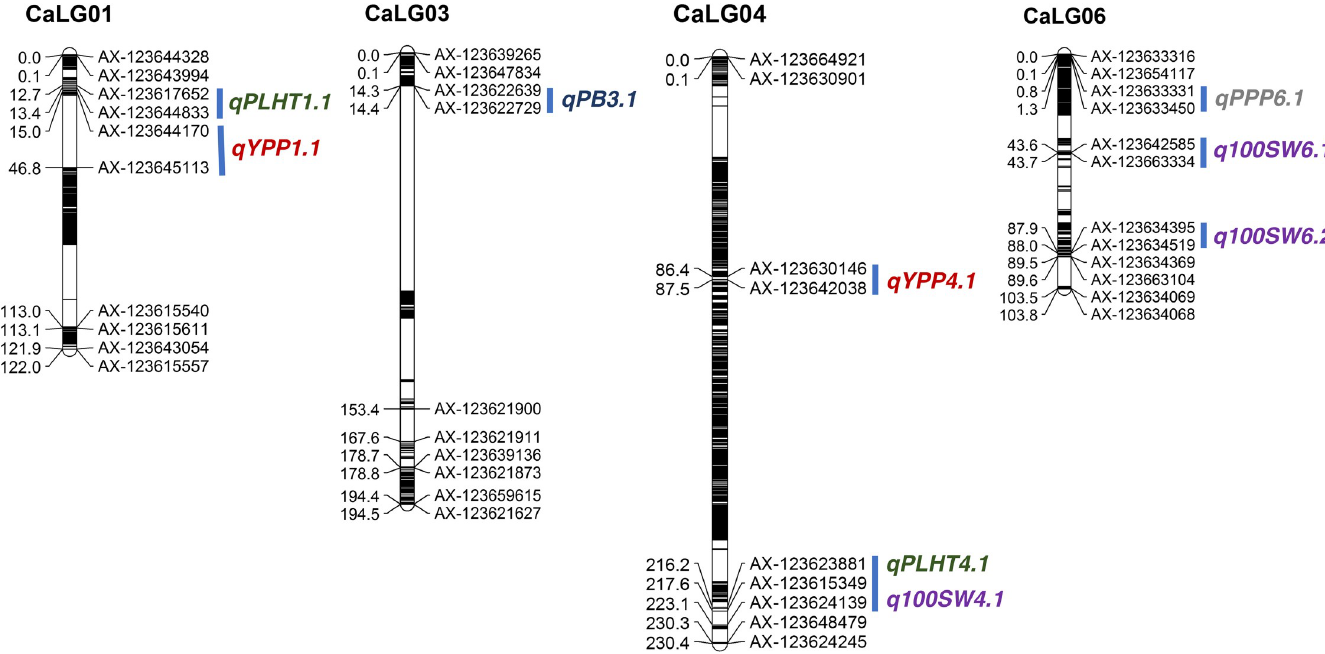
Fig 1. Graphical representation of linkage map with major-effect QTLs mapped for yield, yield components and agronomic traits in the ICC 4958 × DCP 92–3 RIL population. Major-effect QTLs for five traits are represented using their QTL names on the genetic